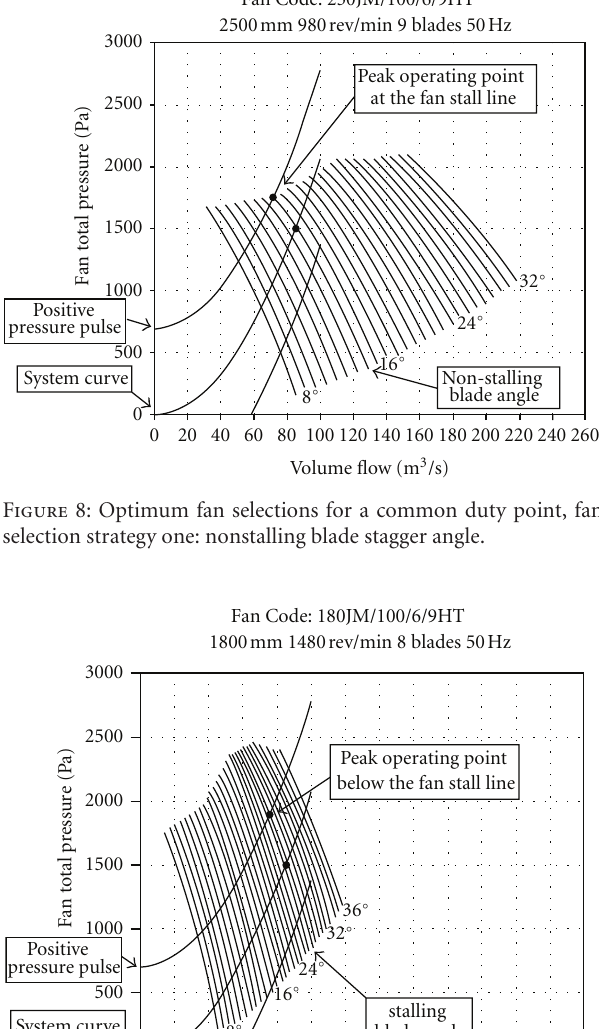
Table 4: Factors impacting on fan capital and through life cost.